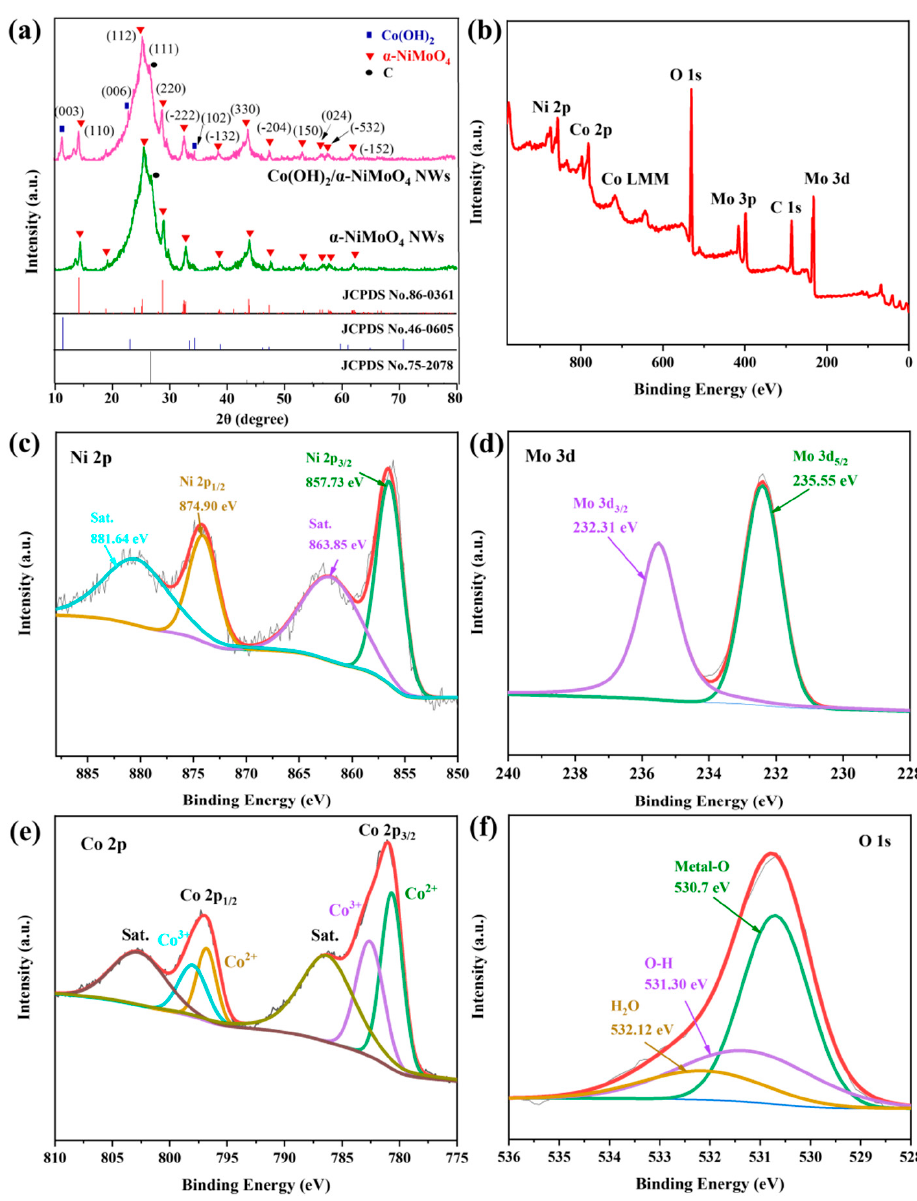
Figure 2. ( a ) XRD patterns of α -NiMoO 4 NWs/CC and Co(OH) 2 / α -NiMoO 4 NWs/CC; ( b ) XPS spectra of survey scan; ( c ) Ni 2p; ( d ) Mo 3d; ( e ) Co 2p; ( f ) O 1s of Co(OH) 2 / α -NiMoO 4 NWs/CC. The chemical and bonding states of Co(OH) 2 / α‐ NiMoO 4 NWs/CC were analyzed by X ‐ ray photoelectron spectroscopy (XPS). In Figure 2b, the XPS survey scan spectrum of the Co(OH) 2 / α‐ NiMoO 4 NWs/CC confirms the presence of all five elements of Co, Ni, Mo, O, and C. The characteristic peak at 855.70 eV in Figure 2c corresponds to Ni 2p 3/2 , the characteristic peak at 873.40 eV corresponds to Ni 2p 1/2 , and the energy gap between the two main peaks is 17.7 eV, indicating that Ni mainly exists in the form of Ni 2+ [47]. Meanwhile, the presence of Ni 2p 3/2 and Ni 2p 1/2 satellite peaks at 861.85 eV and 880.9 eV confirms the existence of electronic association in the system, indicating the interaction between Ni and NiO 6 octahedra in α‐ NiMoO 4 [48]. The characteristic peaks at 232.31 eV and 235.55 eV in the spectrum of Mo 3d (Figure 2d) correspond to the orbital binding energy of Mo 3d 5/2 and Mo 3d 3/2 , respectively, and the position of the two main peaks is that of the characteristic peaks corresponding to the Mo element with a +6 valence [49]. In Figure 2e, the peaks located at 782.58 eV and 797.83 eV could be attributed to 2p 3/2 and 2p 1/2 of the Co element with a +3 valence, and the characteristic peaks at 780.66 eV and 796.38 eV correspond to 2p 3/2 and 2p 1/2 of the Co element with the +2 valence [50]. The highly oxidized Co 3+ is reported to be the active site of the electrocatalytic OER [51]. In